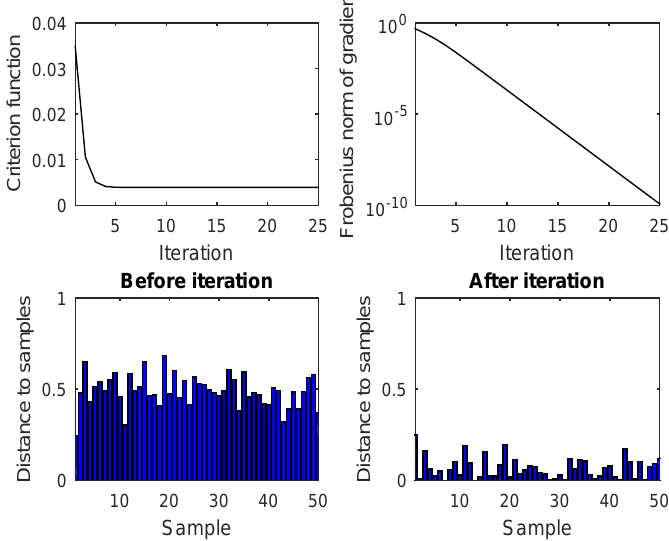
Figure 2. Mean-matrix computation over the pseudo-orthogonal group O ( 1,1 ) : Values of the criterion function in Equation (28) during iteration, Frobenius norm of its pseudo-Riemannian gradient, distances D F ( X , X k ) before iteration ( X = X ( 0 ) ) and after iteration ( X = µ ) .